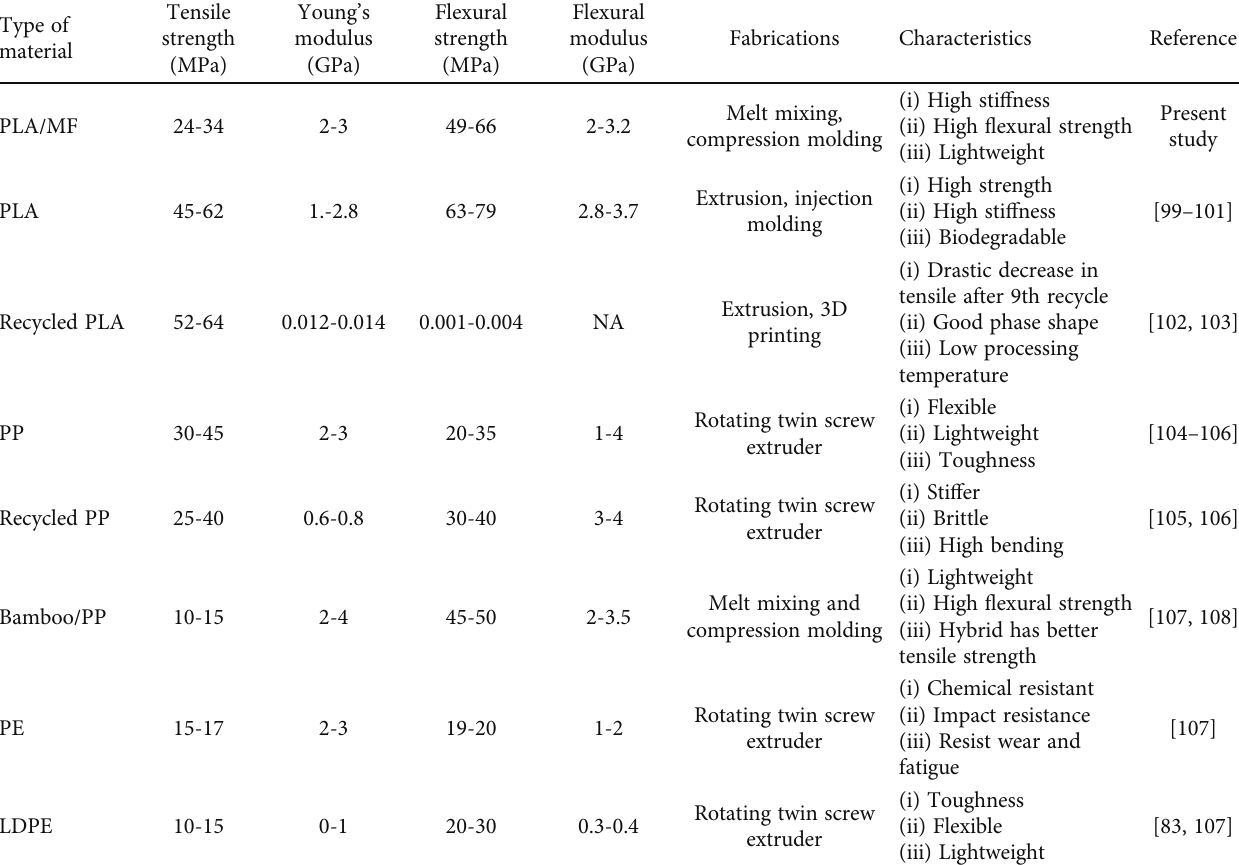
Table 9: Comparison mechanical properties of PLA/MF with thermoplastic based material. Type of material